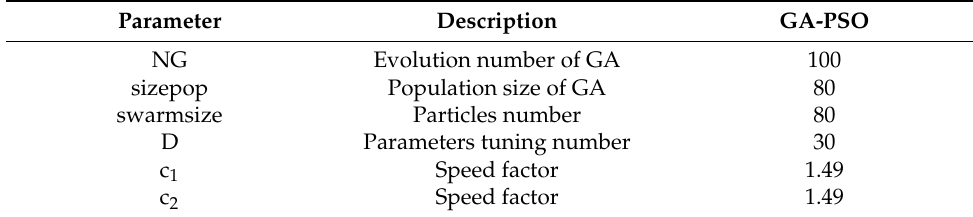
Table 3. Algorithm Parameters of GA-PSO.